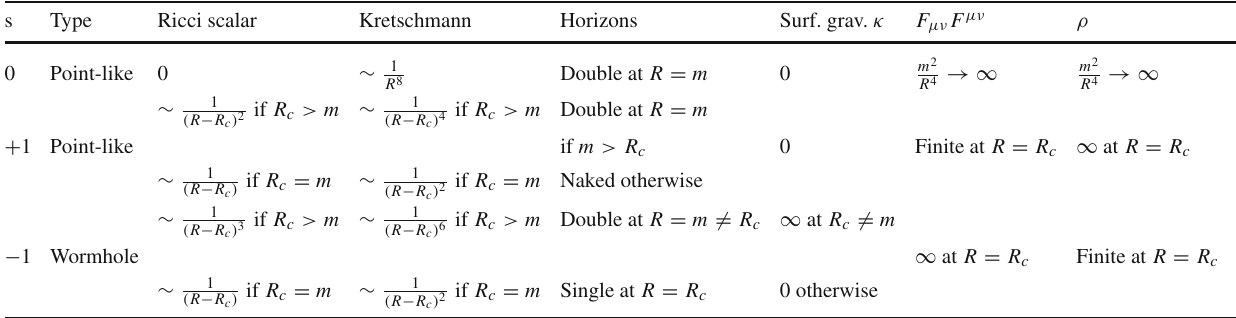
Table 1 Summary of the features of the one-center solutions of GR ( s = 0) and of the two families of configurations studied in this paper ( s = ± 1). The case in which R c = m is considered separately in Sect.